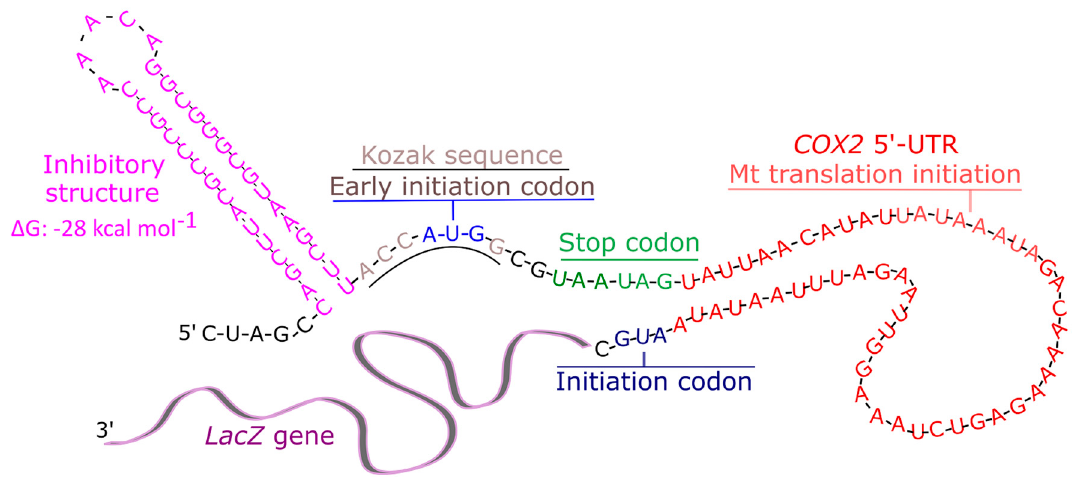
Figure 1. Schematic representation of the β -galactosidase mRNA designed to limit cytoplasmic translation. Various features of the 5 (cid:48) -UTR for this mRNA are shown in different colors. Elements designed to limit cytoplasmic translation include an inhibitory structure (pink), an early initiation codon (light blue) within Kozak sequence (light gray) and early tandem stop codons (green). COX2 5 (cid:48) -UTR (red) mediates mitochondrial translation; its key translation initiation sequence (Mt translation initiation) is indicated (light red).